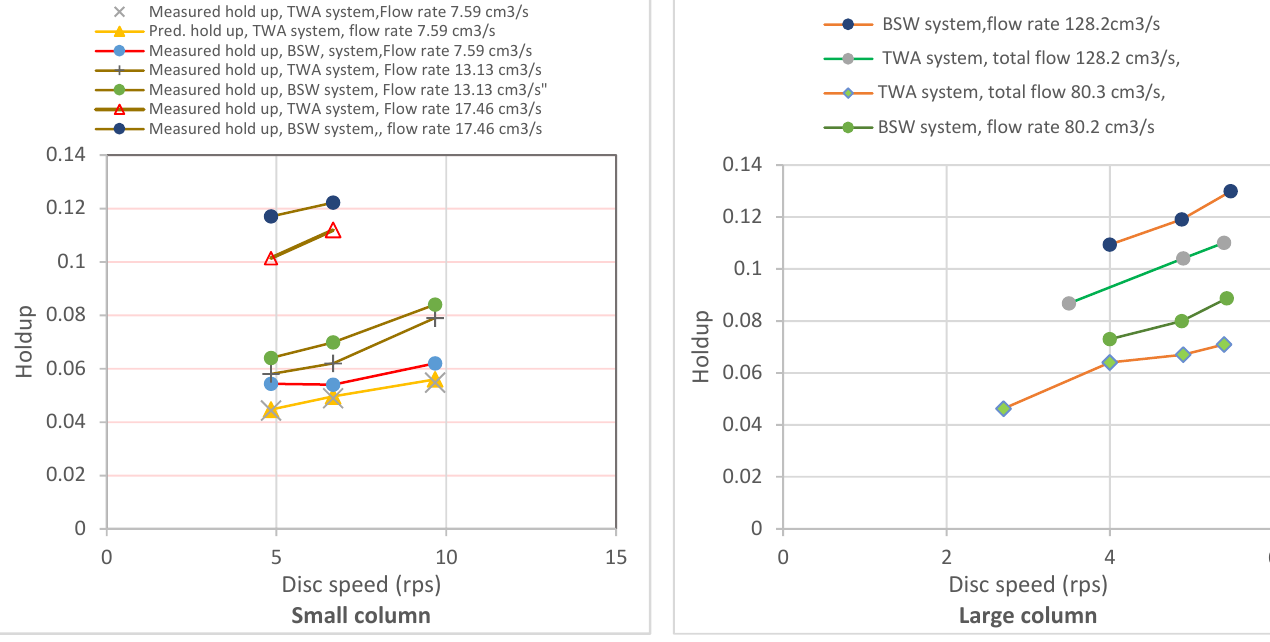
Figure 8. Dispersed phase holdup experimentally measured in small (7.62 cm) and large (21.9 cm) RDC, using the BSW system (distributors I – IV).